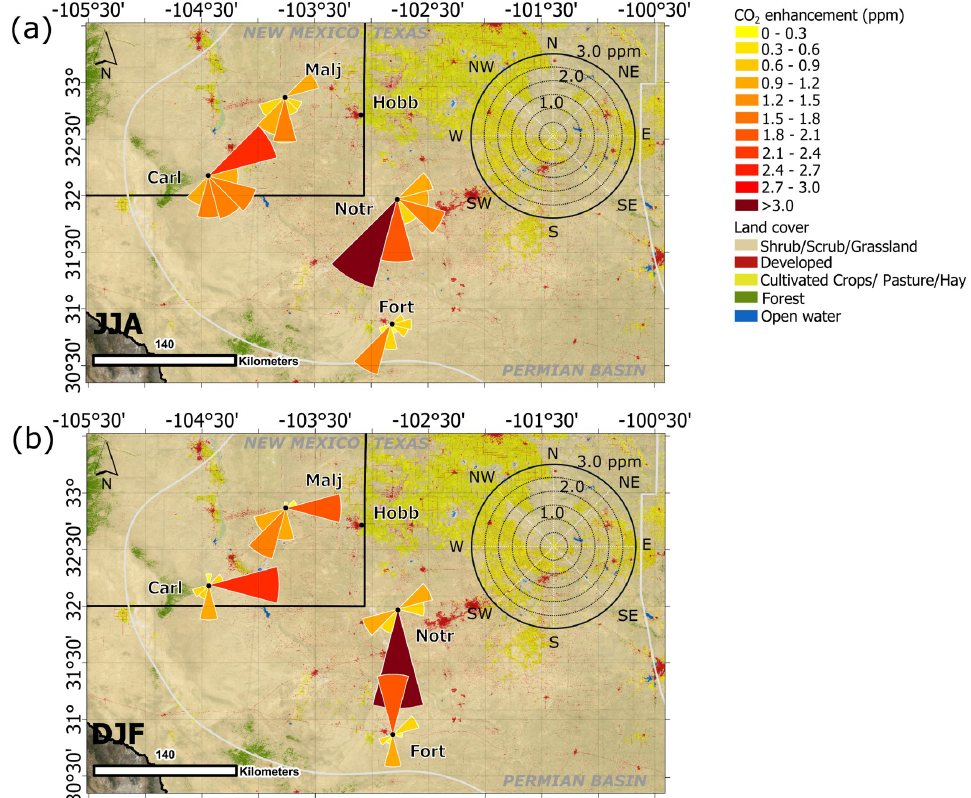
Figure 9. Carbon dioxide enhancements at each tower location. The background for the figures is the land cover from NLCD (National Land Cover Database; MRLC, 2019) for the Permian Basin. (a) CO 2 enhancements during summer months, i.e., June, July, August (JJA). (b) CO 2 enhancements during winter months, i.e., December January, February (DJF). The “triangles” represent the mean of the afternoon (20:00–23:00 UTC) enhancements coming from the indicated direction. The gray boundary delimits the Permian Basin, while the black line is the boundary between New Mexico and Texas. Credits for base map: Esri, DigitalGlobe, GeoEye, Earthstar Geographics, CNES/Airbus DS, USDA, USGS, AeroGRID, IGN, and the GIS User Community.